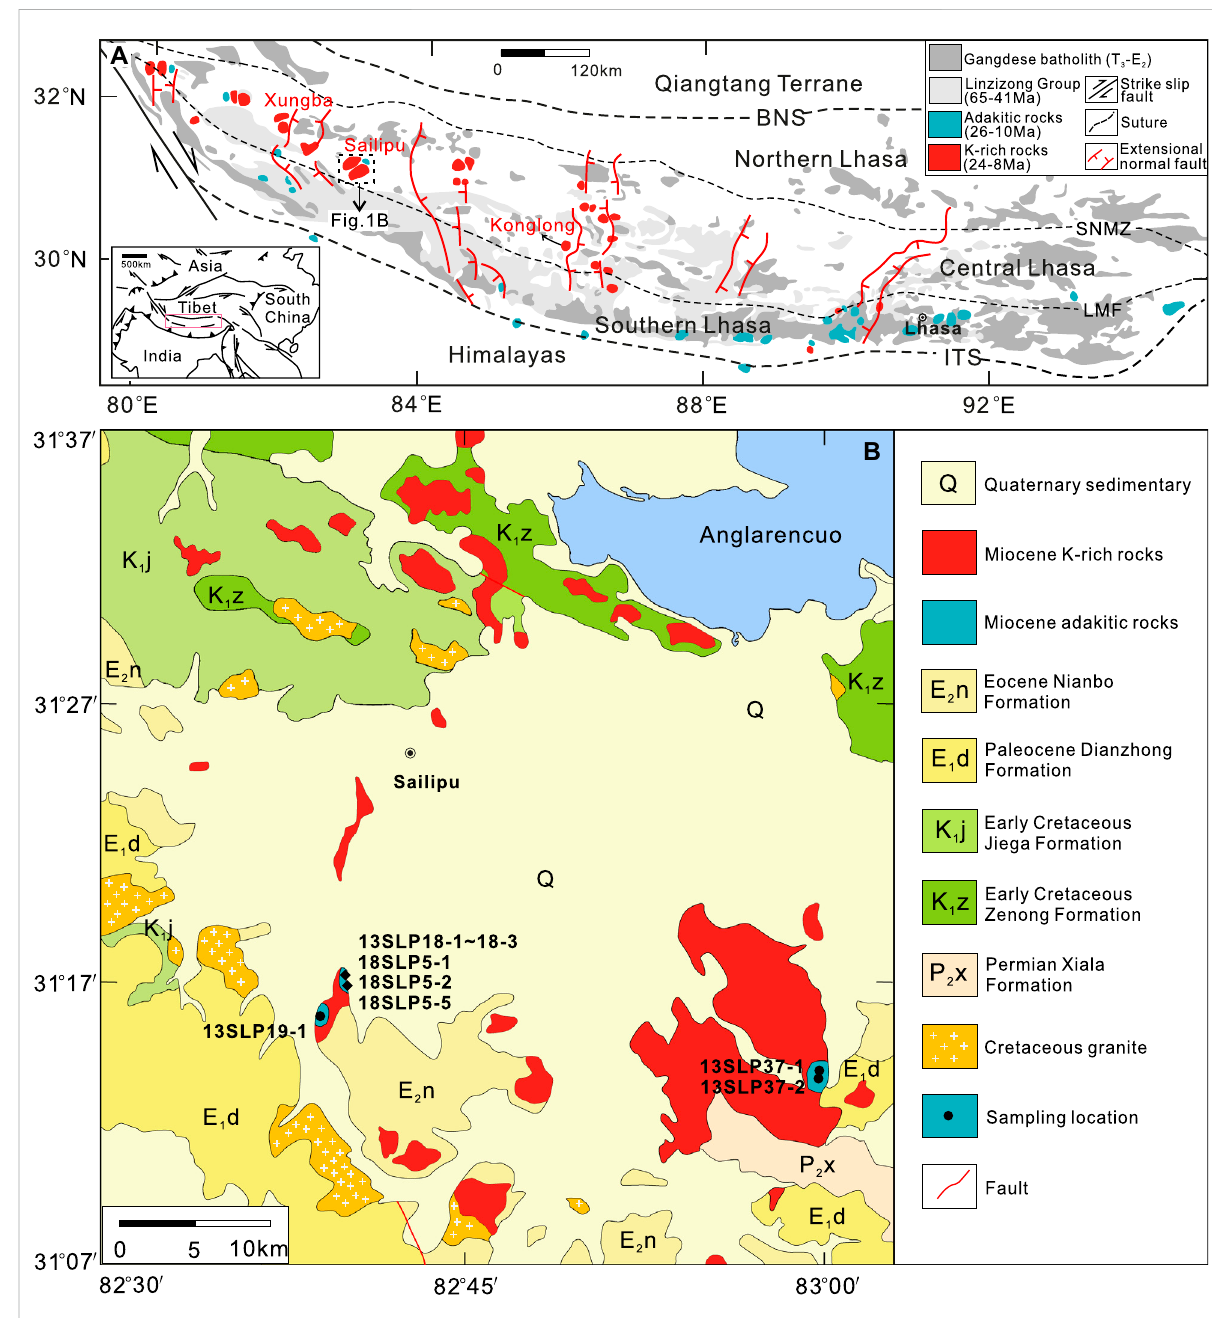
FIGURE 1 (A) A simpli fi ed geologic map of the Lhasa block showing distribution of Cenozoic magmatic rocks, modi fi ed from Guo et al. (2015). BNS, Bangong – Nujiangsuture;ITS,Indus – YarlungZangbosuture;SNMZ,ShiquanRiver – NamTsoMélangeZone;LMF,Luobadui –